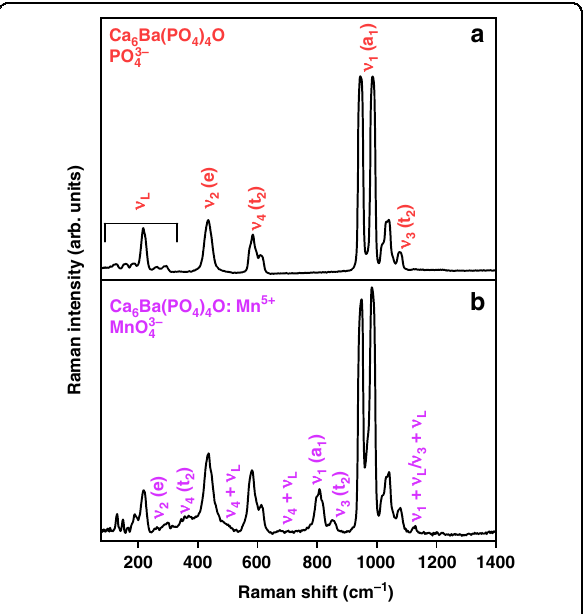
Fig. 3 Vibrational properties of Ca 6 Ba(PO 4 ) 4 O:Mn 5 + . a Raman scattering spectra of